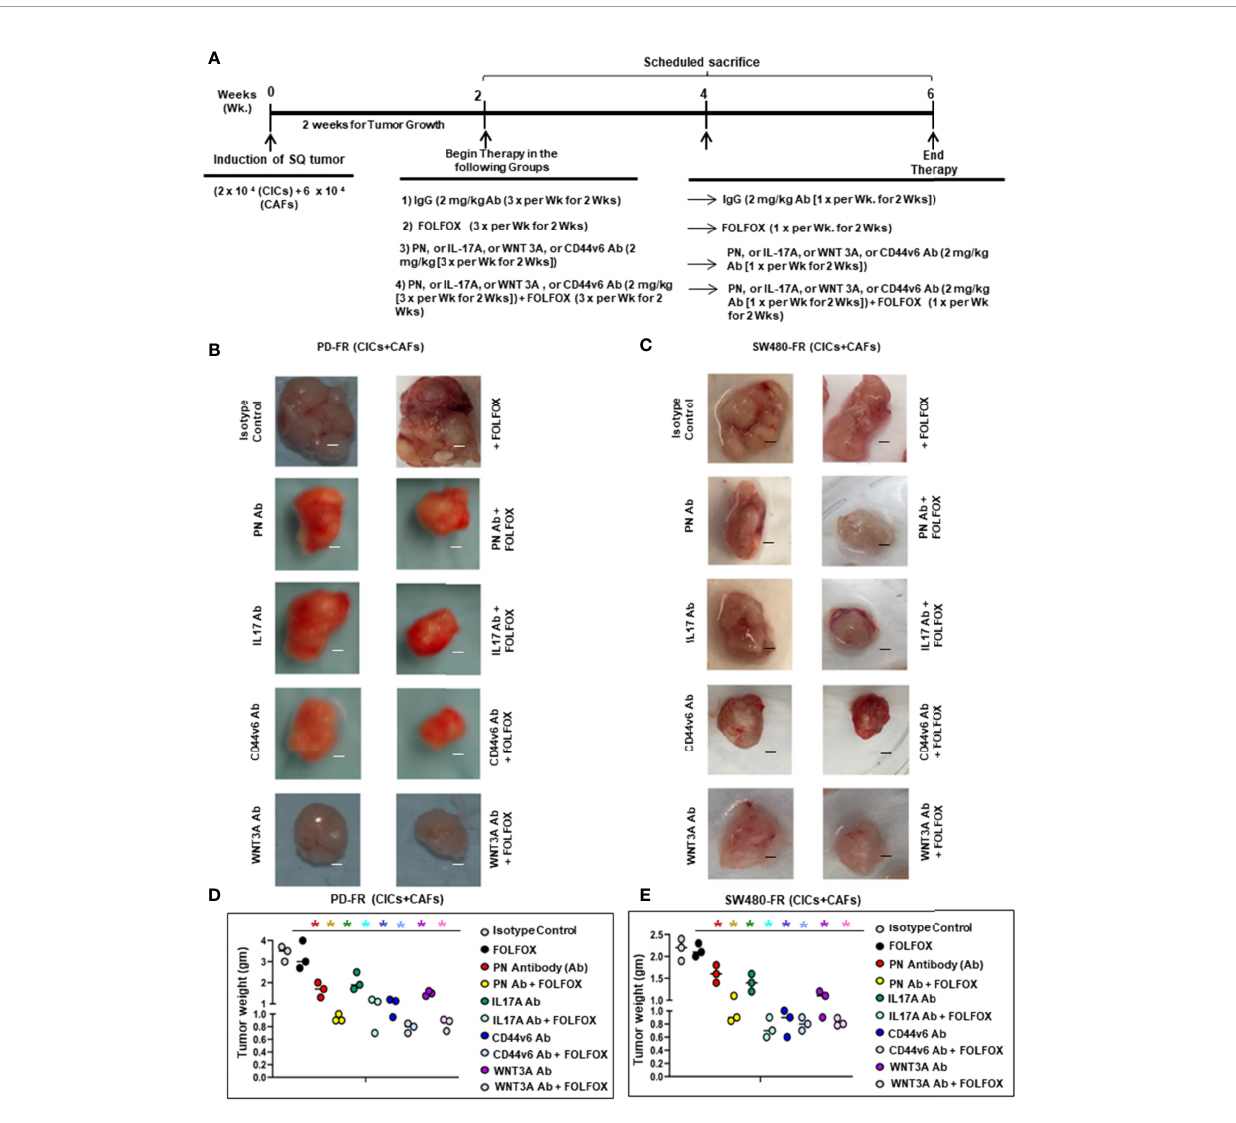
FIGURE 8 | FOLFOX induced PN, WNT3A and IL17A signaling regulates CIC growth in vivo . (A), Timeline is shown for antibody treatments with and without FOLFOX in xenograft tumors implanted by a mixture of CICs plus CAFs from PD-FR human tissues (B, D) and from SW480-FR xenograft tumor cells (C, E) . The dependences of CICs on IL17A, WNT3A, PN and CD44v6 were evaluated in vivo . 2 x10 4 CICs and 6 x 10 4 CAFs were injected into mice. When tumors reached to approximately 0.3 cm 3 in volume, treatments were initiated. Detailed treatment procedure is in Methods. Mice were weighed, and the tumor volumes were measured every other day for 4 weeks. (B, C), Representative tumors from three experiments are shown from mice treated as indicated. (D, E), Tumor weights from the experiments in (B, C) for each tumor set at the end of treatment after 4 weeks are shown. Data presented in (D, E) are Mean ± SD.; n = 5 mice/group independent replicates in three independent experiments; (B) , *, P < 0.05 were considered signi fi cant, inhibition in tumor growth represented by tumor weight and tumor volume in treatment groups compared to IgG control groups. ANOVA, followed by Bonferroni ’ s post-hoc test was used to assess the signi fi cance. Scale bars, 1